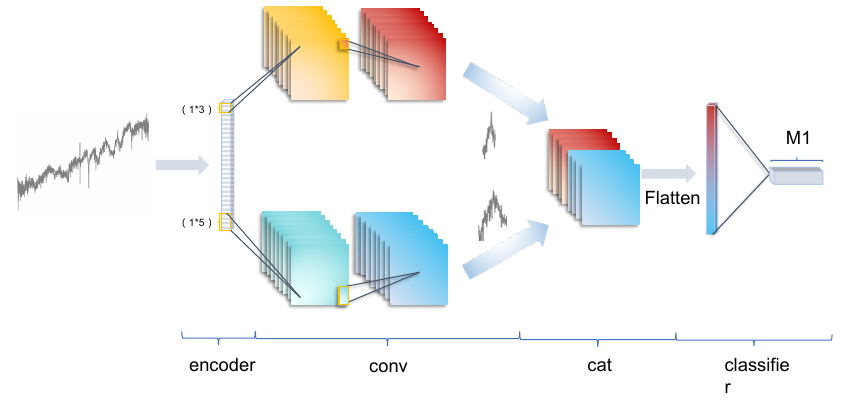
Figure 10. The structure of